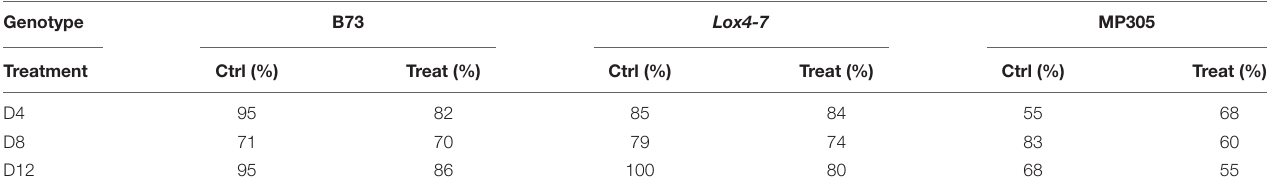
TABLE 5 | True positive rates of identifying control or treated plants based on Raman spectra of leaves from field-grown maize. Genotype B73 MP305